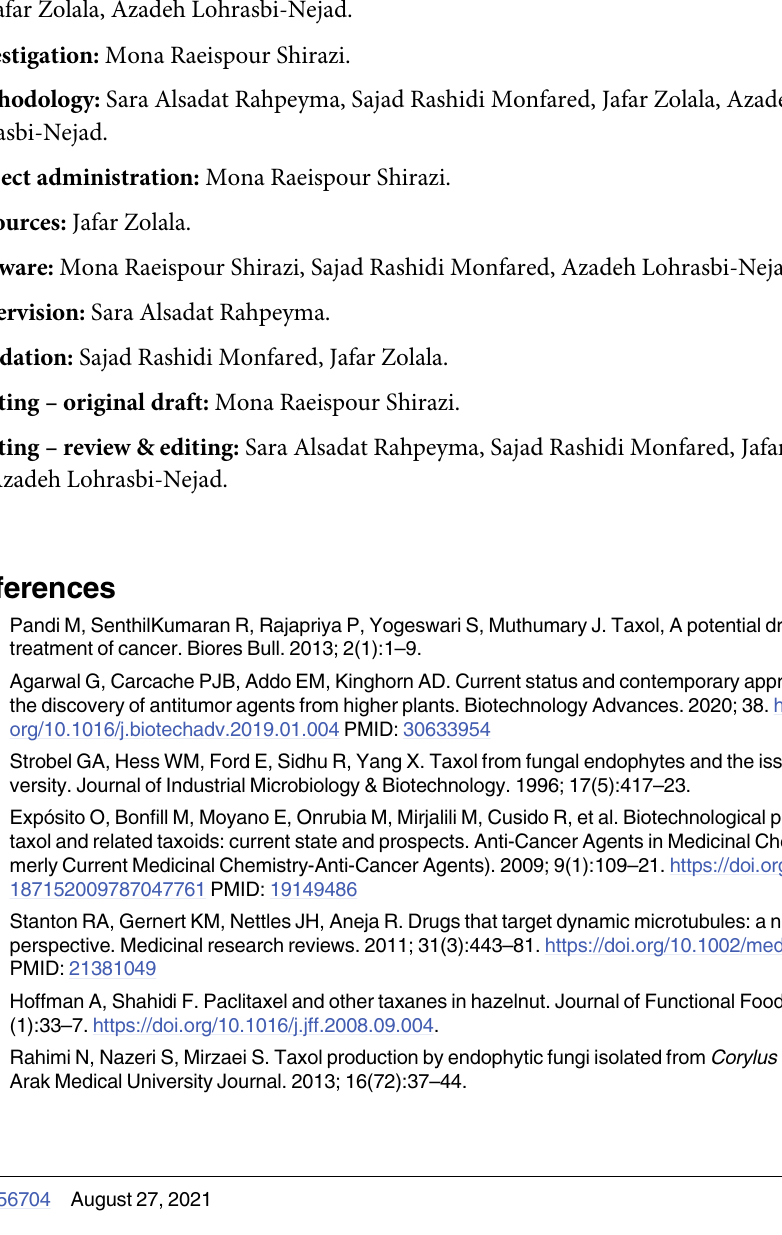
S1 Table. PCR primers sequences for GAPCH gene. (Thermo Scientific (Fermentase), cat no.: K1621, USA). S2 Table. The results of ORFs, online software. The most portable framework and the tallest of ORF are in + 1 and the nucleotide of 97 to